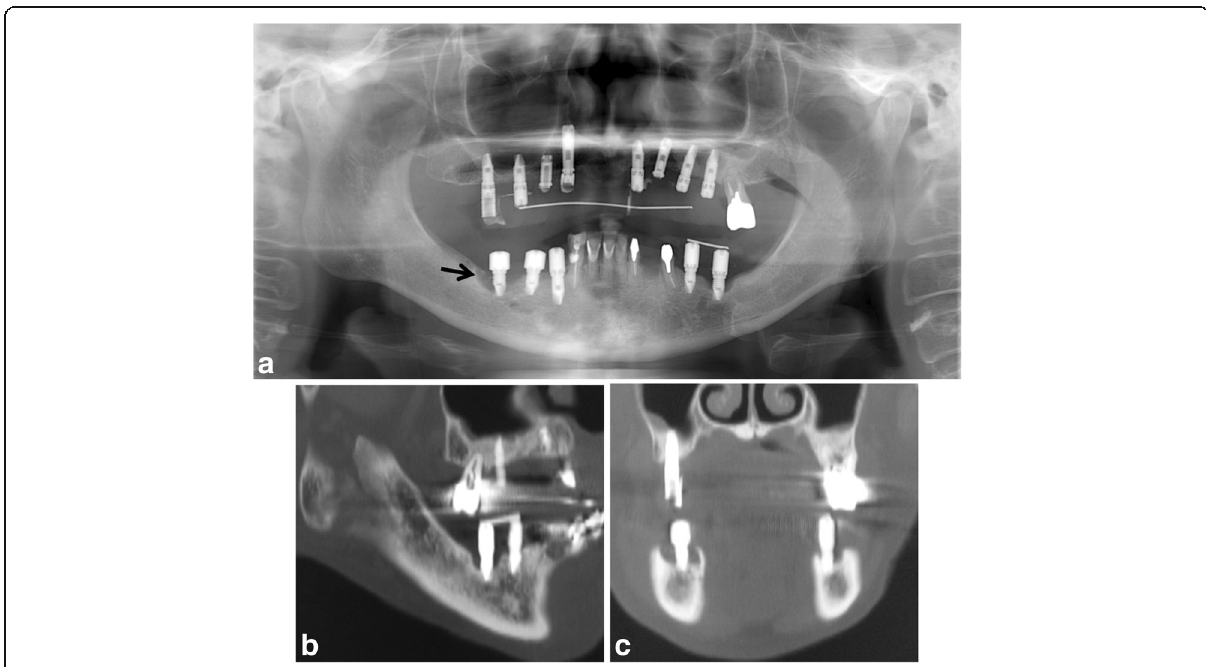
Fig. 2 a Panoramic radiograph showing marked alveolar bone resorption surrounding the dental implant replacing the right mandibular first